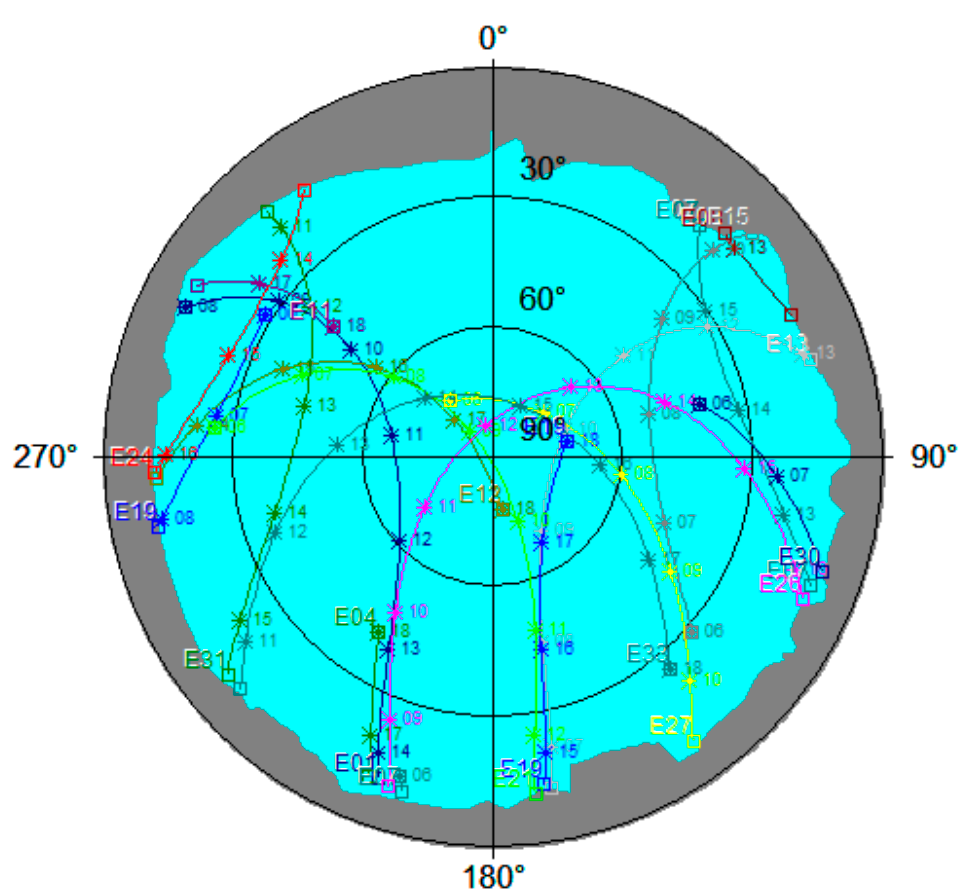
According to the number of visible GAL satellites at the station A above the visible horizon for the time window 8–17 CET, an observation plan was set up and is presented in Table 1.